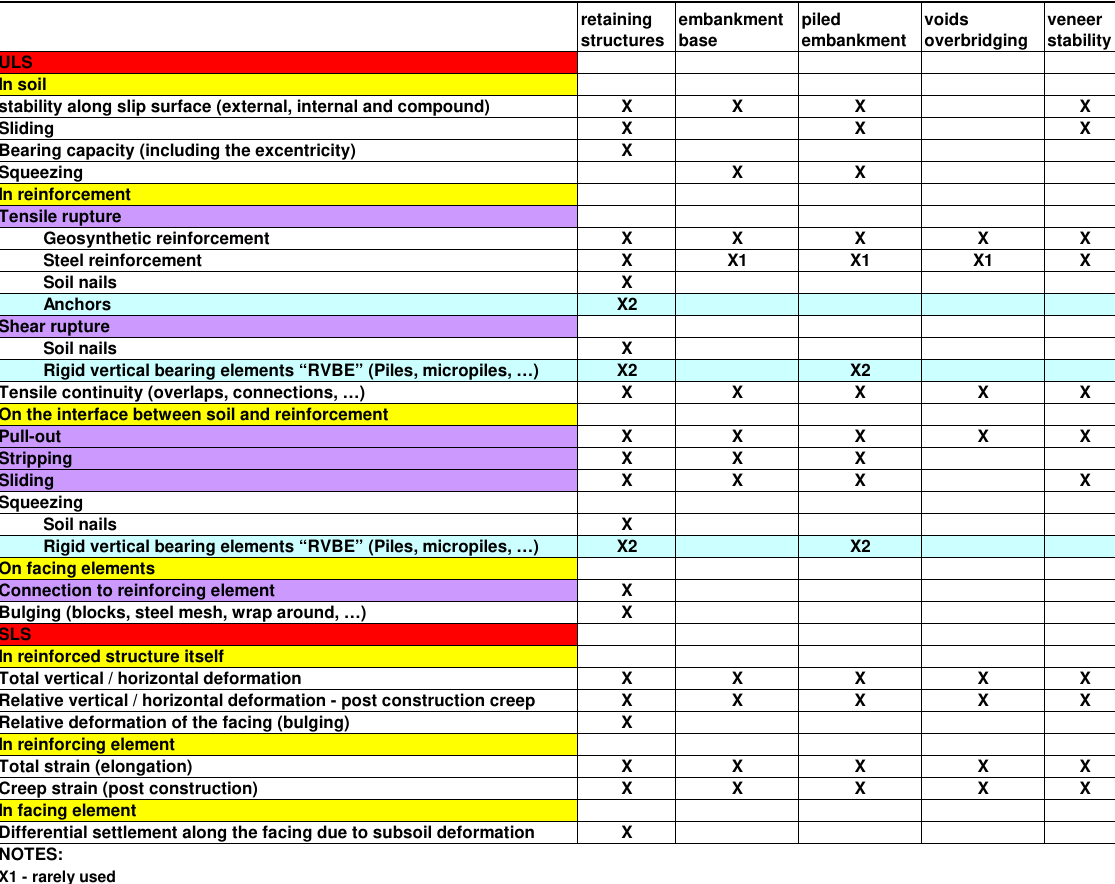
Figure 1. Matrix of identified limit states and reinforced soil